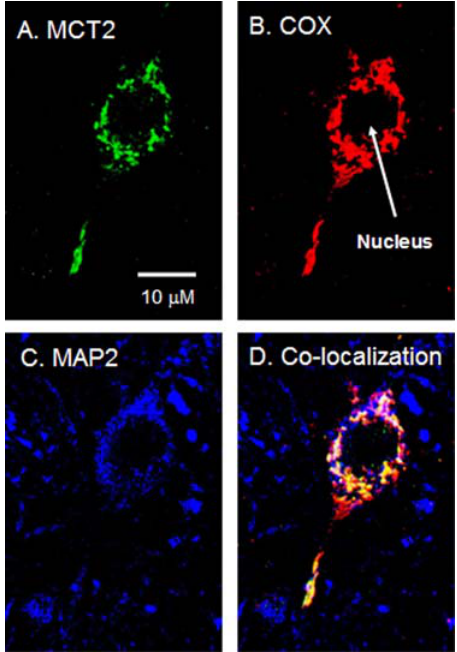
Figure 3. Immunohistochemical images of rat brain cross- sections demonstrating mitochondrial MCT2 in hippocampal neurons. Superposition of signals from probes for MCT2 (A, green), COX (B, red) and MAP2 (C, blue) showed clear colocalization (D, yellow/ white) in neurons. Scale bar=10 m m.